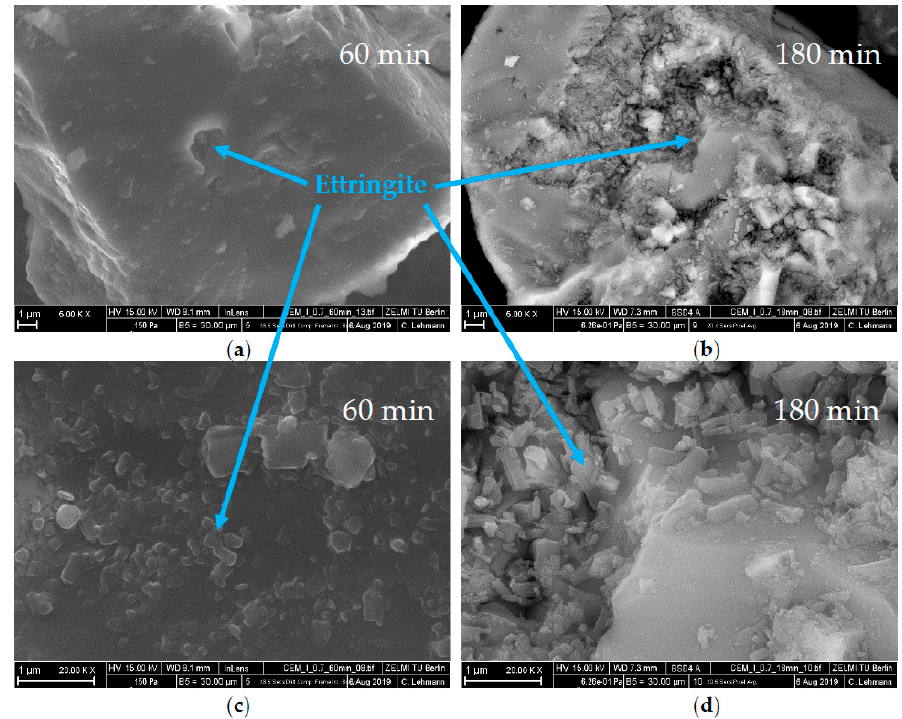
Figure 12. SEM images of CEM I with 0.7 wt% of SP (delayed addition) and a w/c ratio of 0.36 after a time of ( a , c ) 60 min and ( b , d ) 180 min. Materials 2020 , 13 , x FOR PEER REVIEW